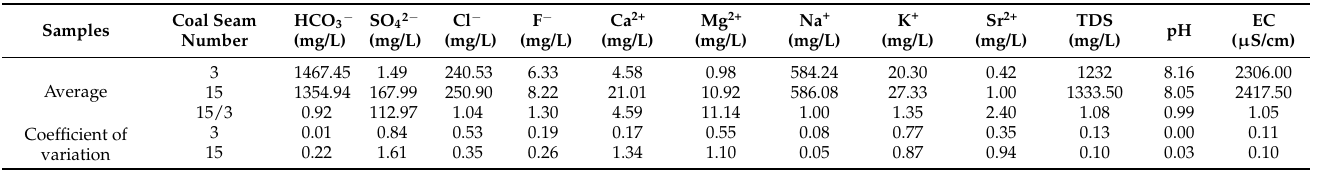
Table 2. Statistics of ionic compositions in produced water samples of No. 3 and No. 15 coal seams.